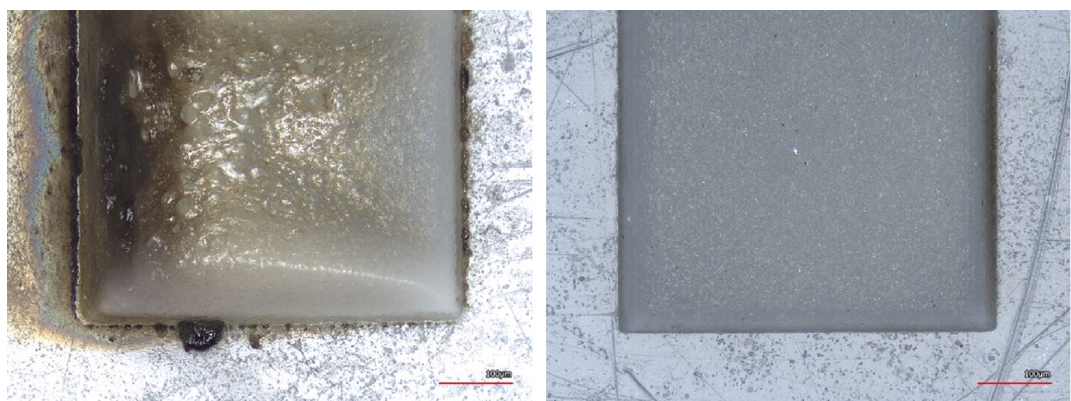
Figure 8. Different recipes ablating an ABS plastic sample. The left sample is lasered with an improper and the right one is lasered with a proper lasering recipe.